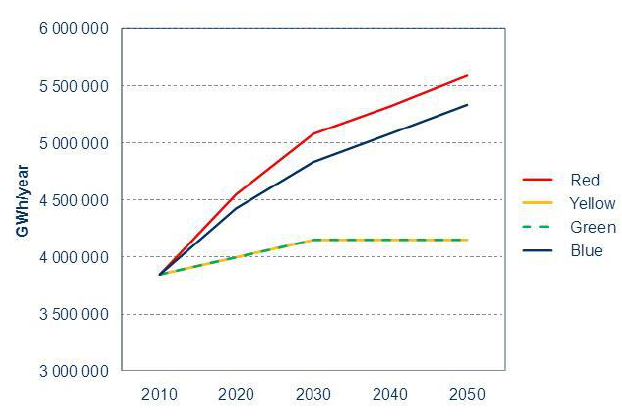
Fig. 3. Development of gross electricity demand in all